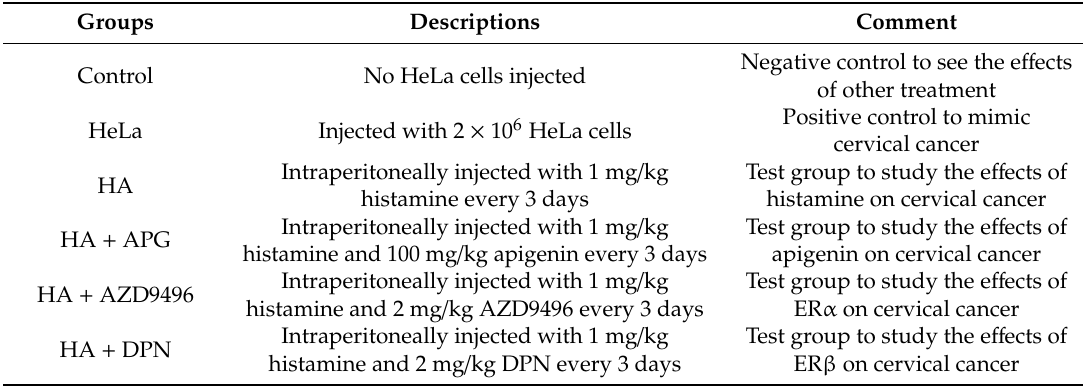
Table 1. Treatment groups and